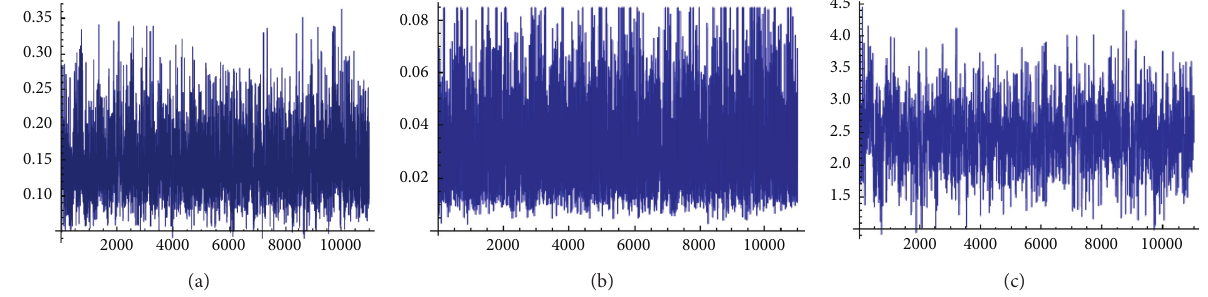
Figure 6: Simulation number generated by the MCMC method for α